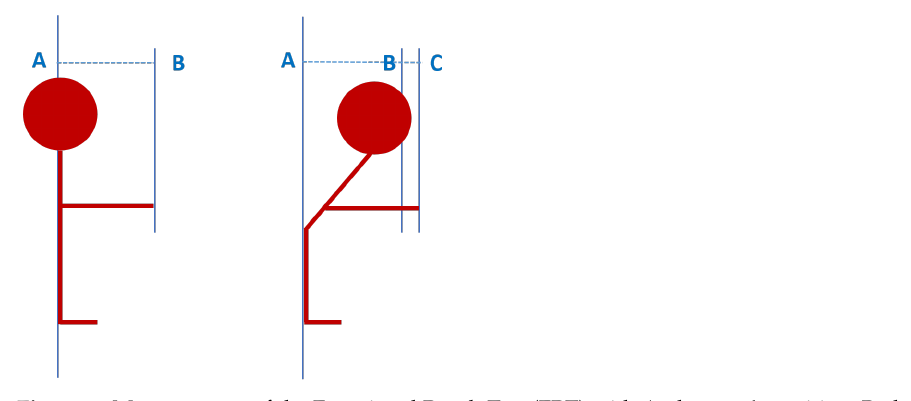
Figure 1. Measurement of the Functional Reach Test (FRT) with A: the user’s position, B: the starting position of the hand, and C: the final position of the hand.